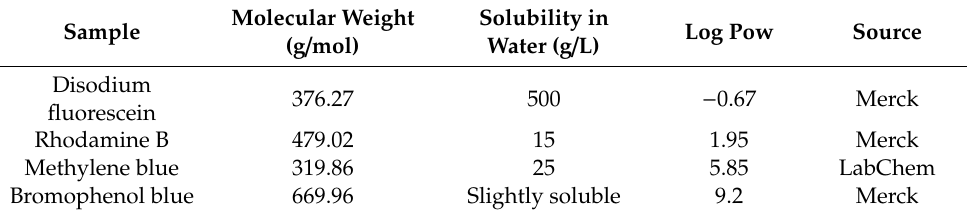
Table 1. Chemical properties of the model compounds